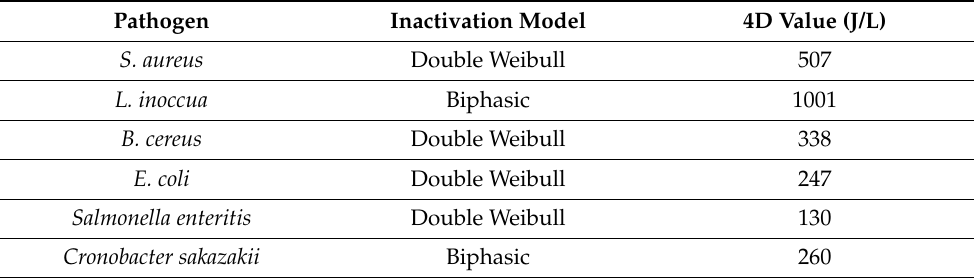
Table 5. 4D values for each pathogen using the best fit inactivation